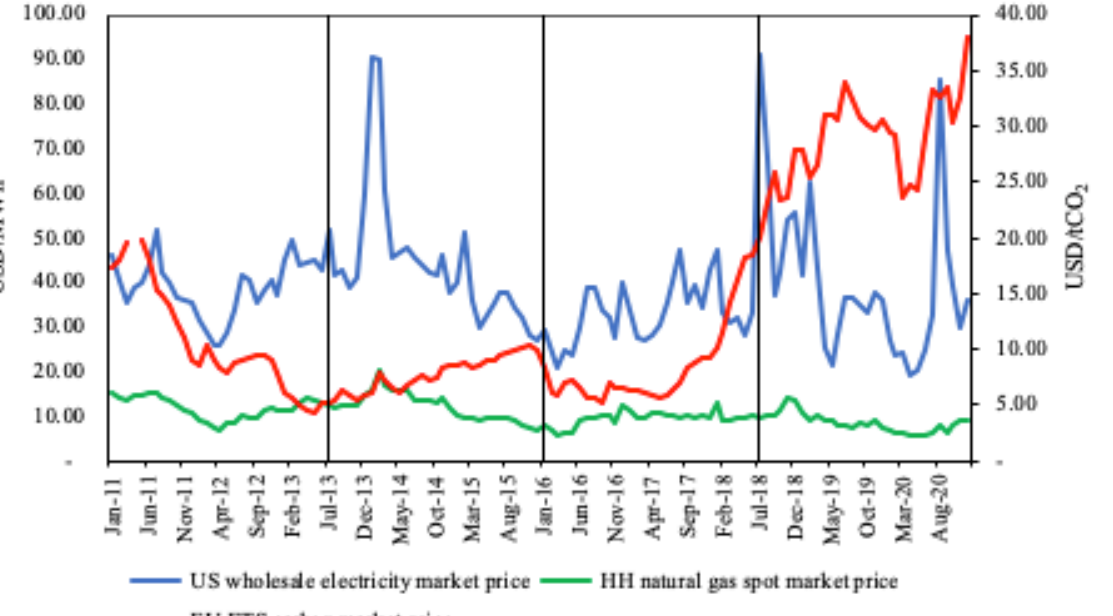
Figure 1. Monthly average wholesale electricity, natural gas, and carbon market prices from January 2011 to December 2020.